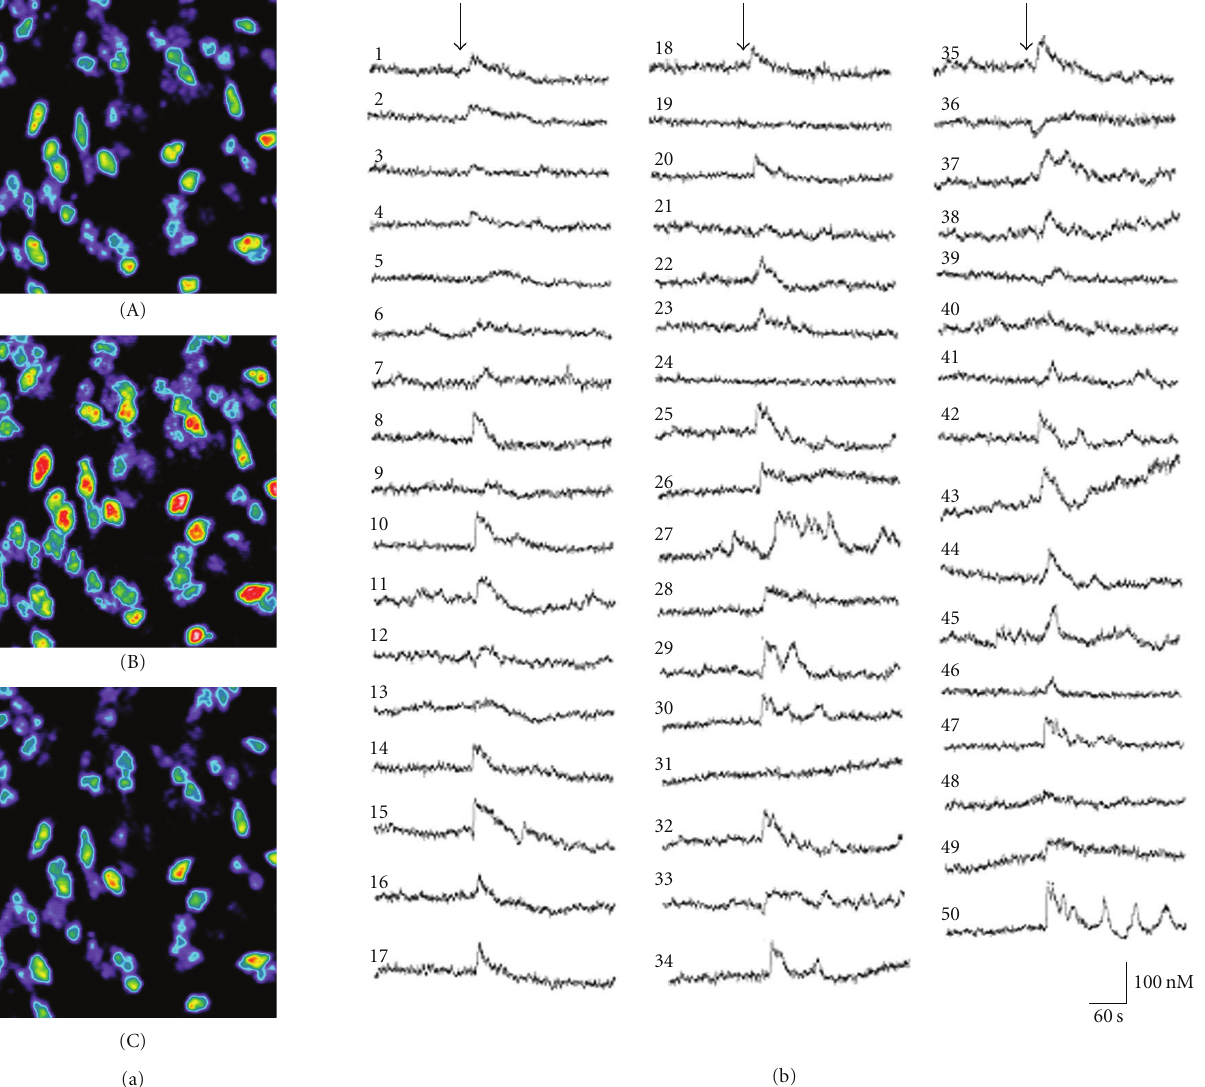
Figure 1: E ff ects of A β P on temporal changes of [Ca 2+ ] i . (a) Pseudocolor images of [Ca 2+ ] i during exposure to A β P(1–40) in GT1-7 cells. A solution of A β P(1–40) (10 μ M) was applied onto fura-2-loaded GT1-7 cells. Temporal changes of fluorescence intensities corresponding to increases in [Ca 2+ ] i were analyzed. (A) 1min before exposure to A β P(1–40); (B) 20sec after exposure; (C) 5min after exposure. (b) Temporal changes of randomly chosen 50 GT1-7 cells in the same field of view before and after the exposure to A β P(1–40) are depicted. The arrow indicates the time of peptide